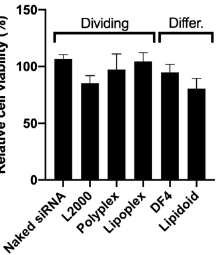
Figure 1. Viability of the dividing and di ff erentiated ARPE-19 after exposure to siRNA / carrier complexes at a siRNA dose of 50 nM. Cell viability was evaluated by MTT (in dividing cells) and an alamarBlue assay (in di ff erentiated cells) after 5 h of exposure to the complexes, and is presented as the percentage of untreated cells. Data are presented as mean + SD, n =